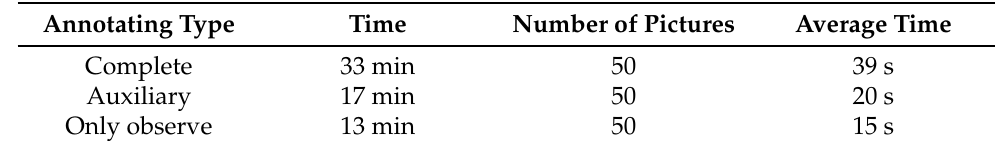
Table 1. Time taken for different annotation methods in Chang’e